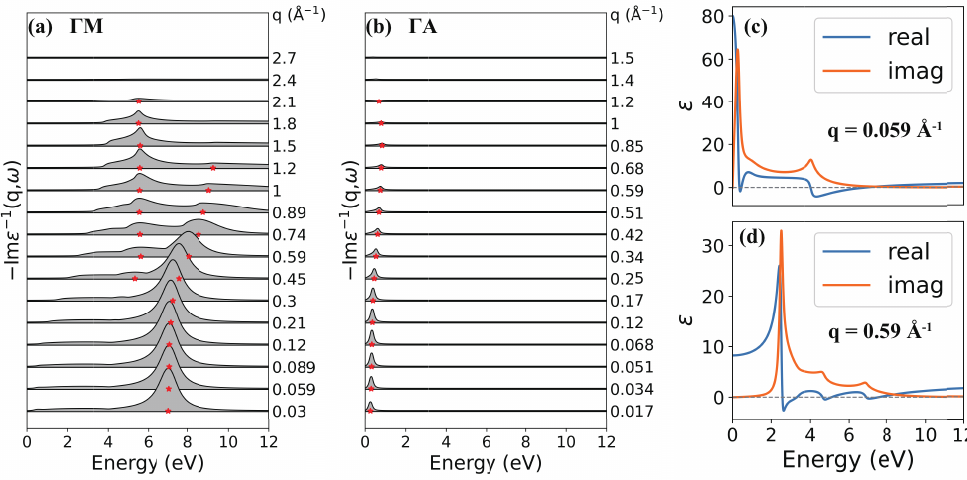
Figure 2. Calculated loss functions along ( a ) the Γ M and ( b ) Γ A directions as a function of q . The peak positions are marked by red stars. Real and imaginary part of dielectric function at ( c ) q = 0.059 Å and ( d ) q = 0.59 Å along the Γ M